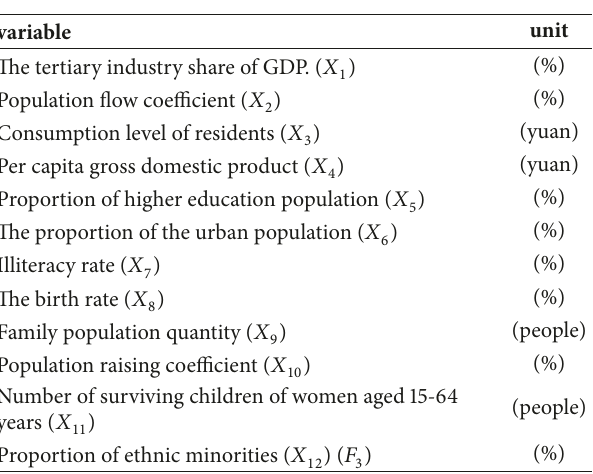
Table 1: Variable interpretation.